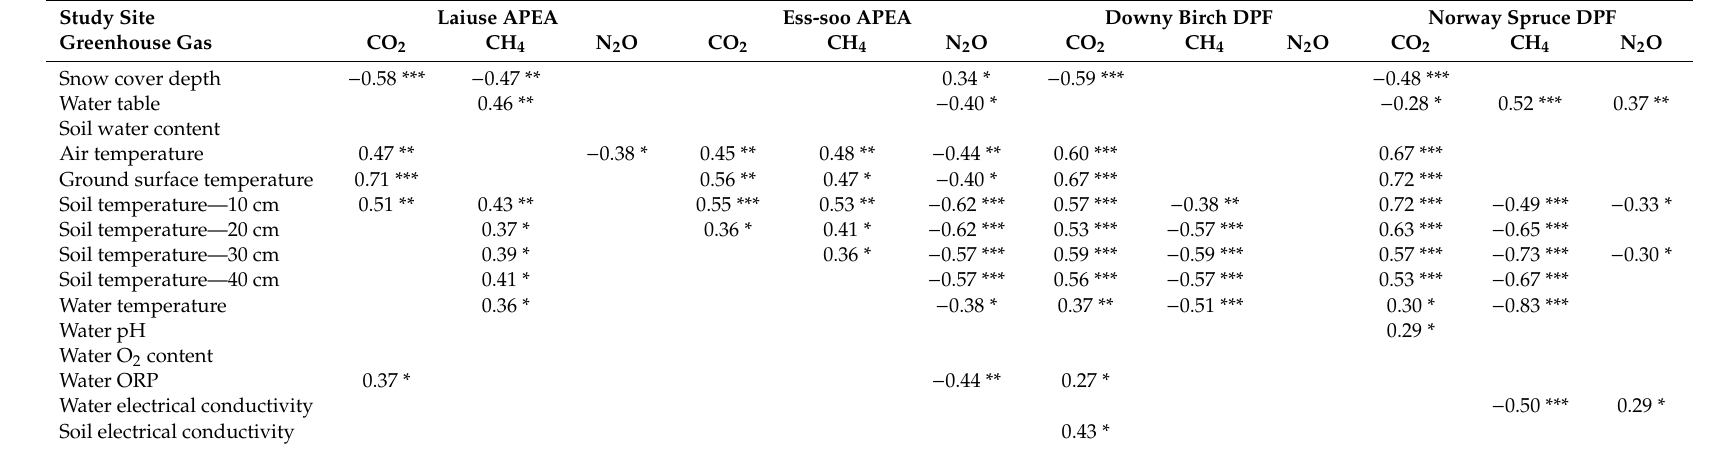
Table 2. Correlations between greenhouse gas emissions and environmental factors in all study sites. The Benjamini–Hochberg-corrected ( p < 0.05) Spearman’s correlation coe ffi cient (R) values are shown. * p < 0.05, ** p < 0.01, *** p < 0.001, non-significant values ( p > 0.05) are not shown. APEA—abandoned peat extraction area, DPF—drained peatland